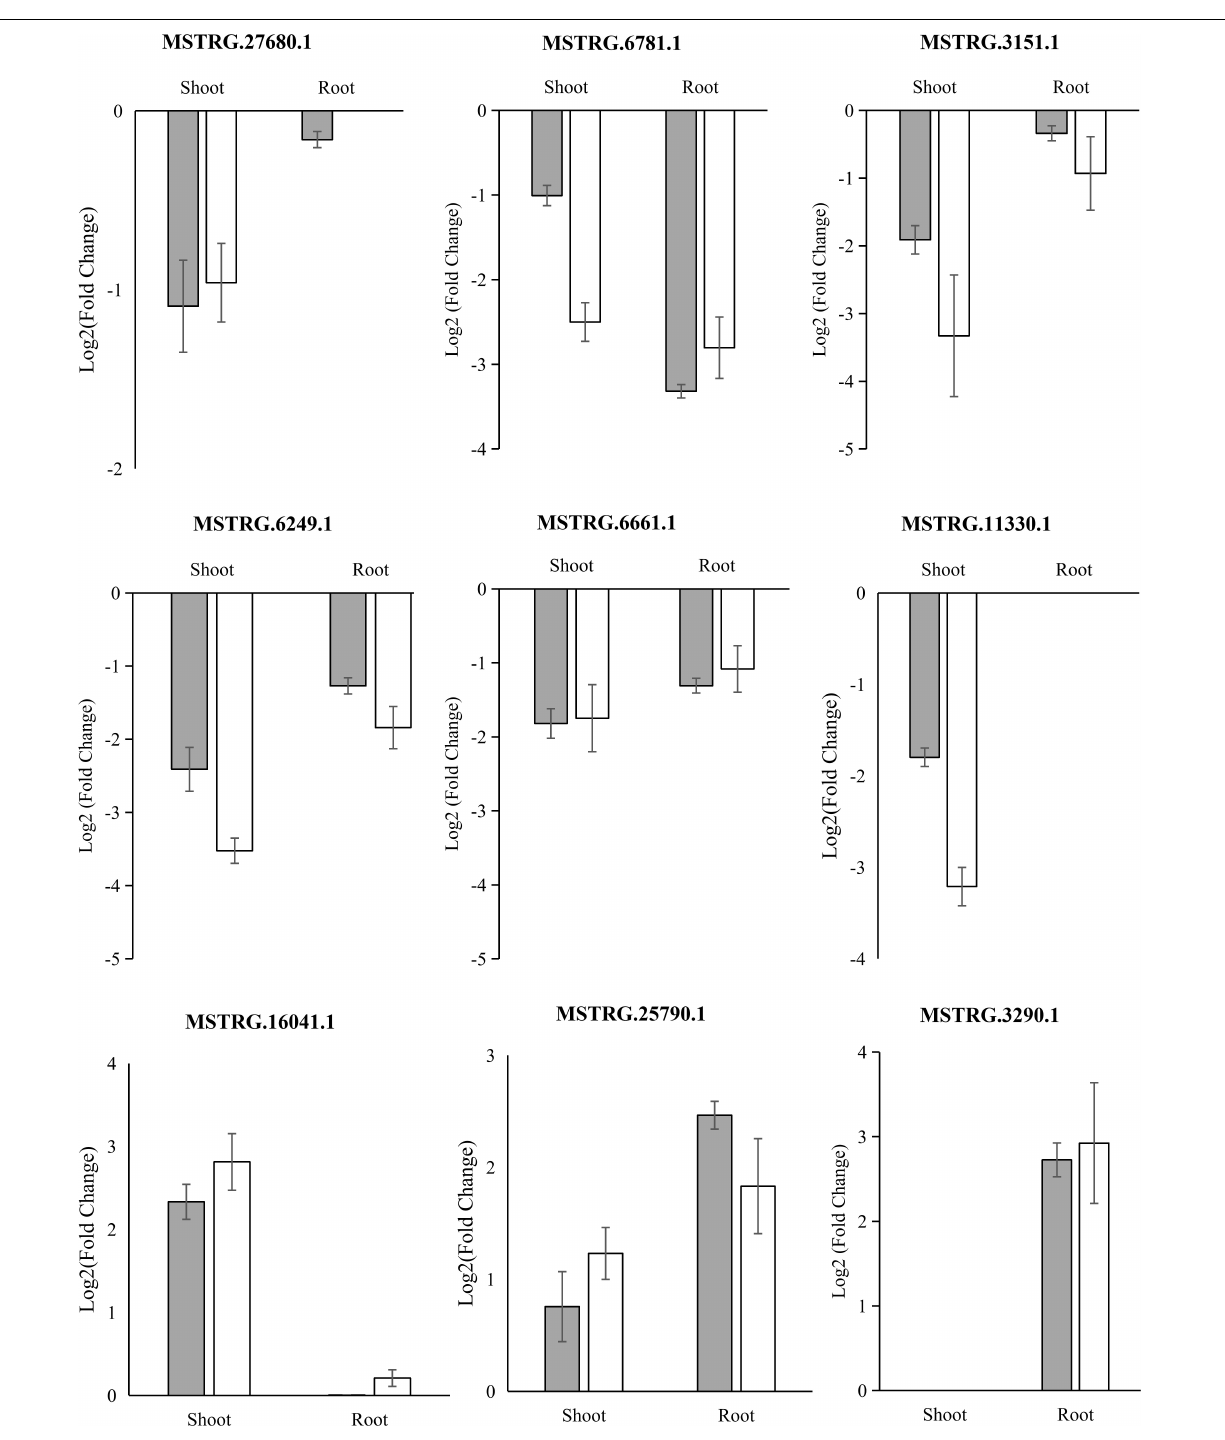
FIGURE 6 | qRT-PCR validation of differentially expressed LncRNAs. Mean ± SE (standard error) of three independent biological replicates was shown and compared with a fold-change value between RNA-seq